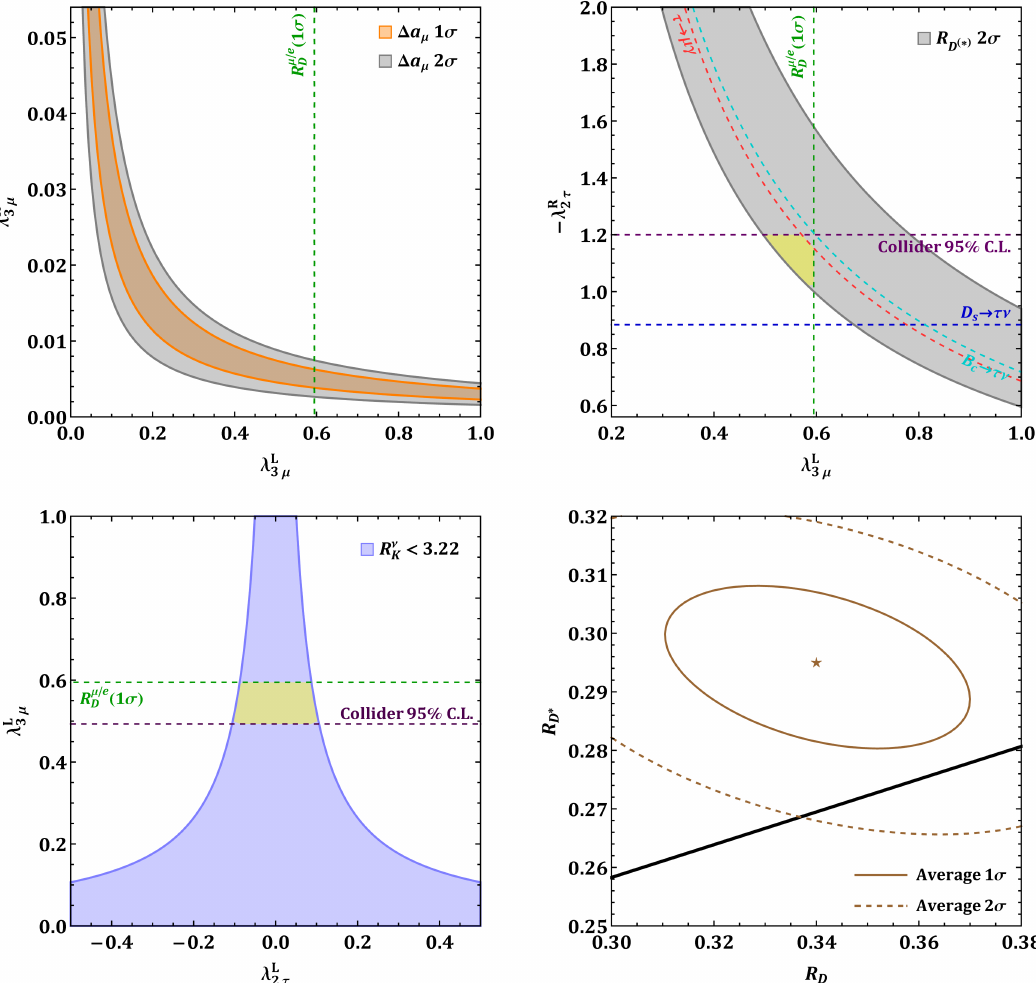
Figure 5 . Allowed regions of the leptoquark Yukawa couplings consistent with the experimental measurements of ∆ a and R at the 1 σ (orange region) and 2 σ (gray regions) levels are presented µ D ( ∗ ) in the top two panels. The limits of other observables are labeled by dashed curves with different colors. In the bottom-left panel, the constraint from B → K ( ∗ ) νν on the parameter space of { λ L , λ L } is represented by the blue-shaded area. The black curve in the bottom-right panel denotes 2 τ 3 µ the prediction for R and R in our model, where the best-fit values (brown star), together with D D ∗ 1 σ (solid ellipse) and 2 σ (dashed ellipse) uncertainties of the averaged R are also exhibited for comparison. In addition, the yellow-shaded regions stand for the allowed parameter space obtained by combining all the observables together. Constraints from δg Z δg Z are rather weak and not shown τ R